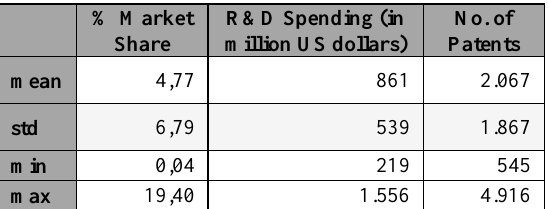
Table 10: Blackberry Descriptive Statistics